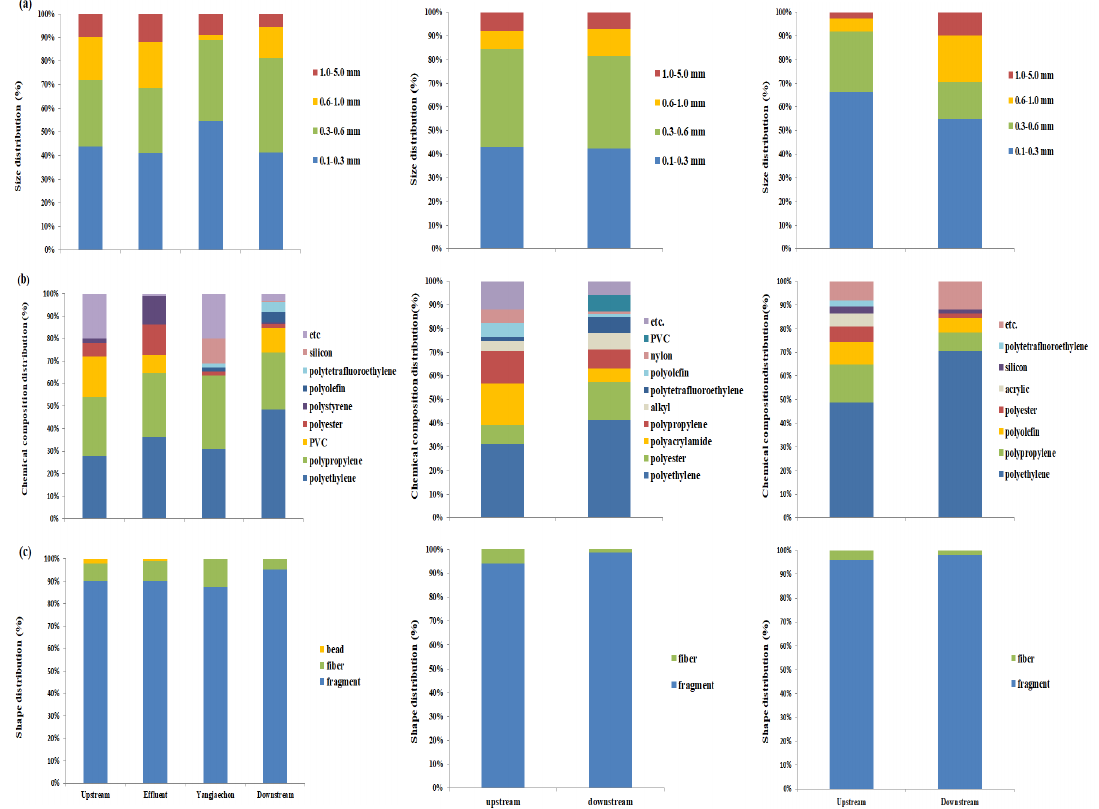
Figure 5. ( a ) Size distribution, ( b ) polymer type, and ( c ) shape distribution of microplastics in water, fish, and sediment of Tanchon stream, Korea.